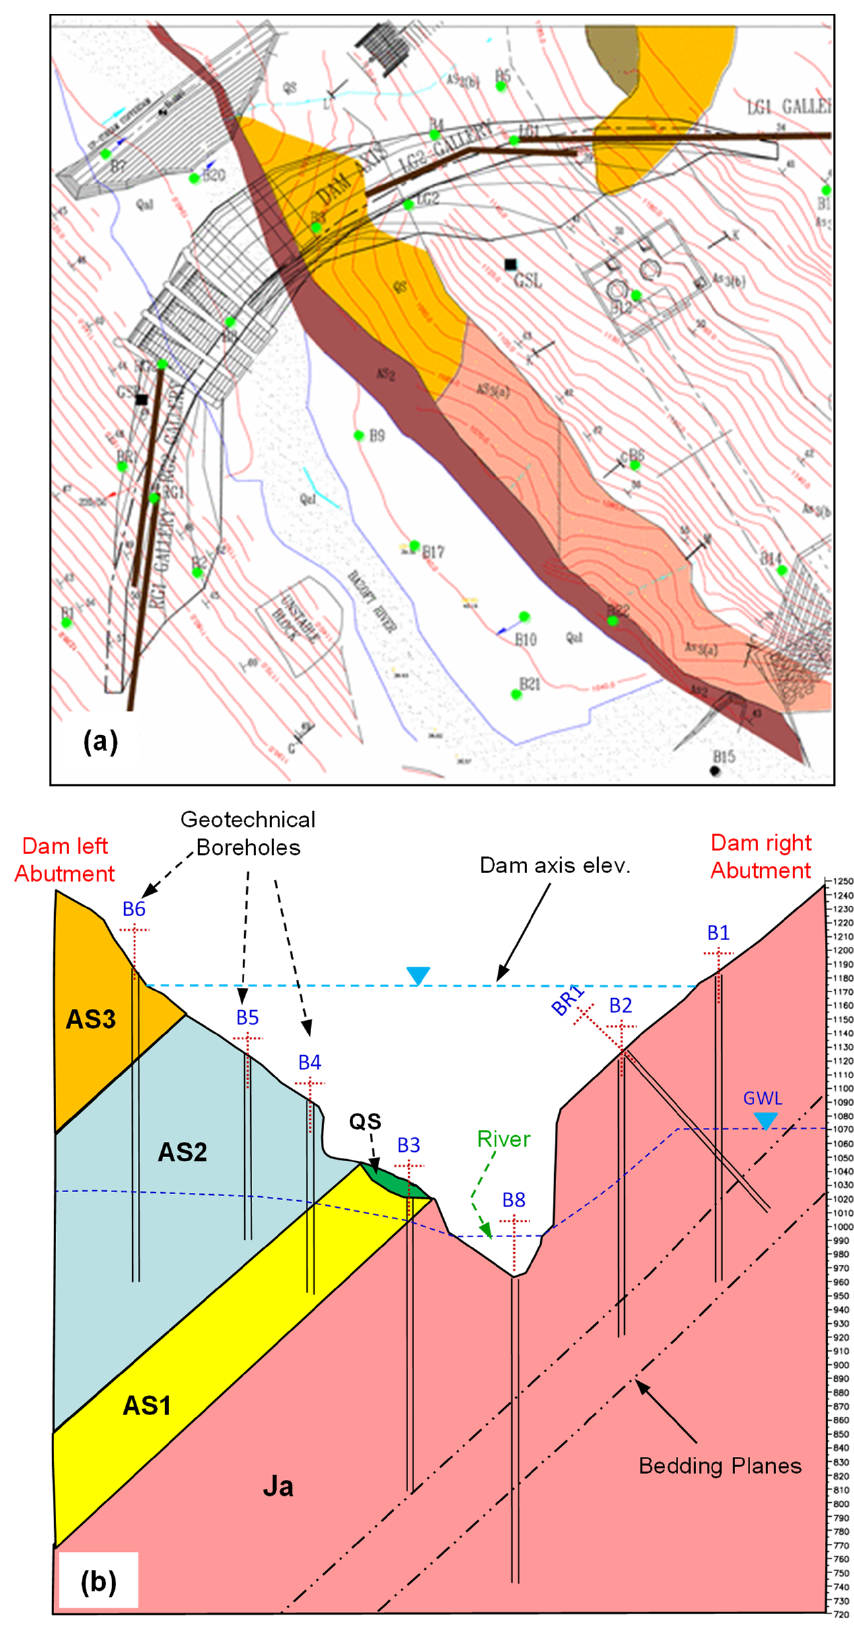
Figure 2. Overall views of Bazoft dam site; ( a ) Plan view of site topography and ( b ) Longitudinal view of abutments geometry and general geology.